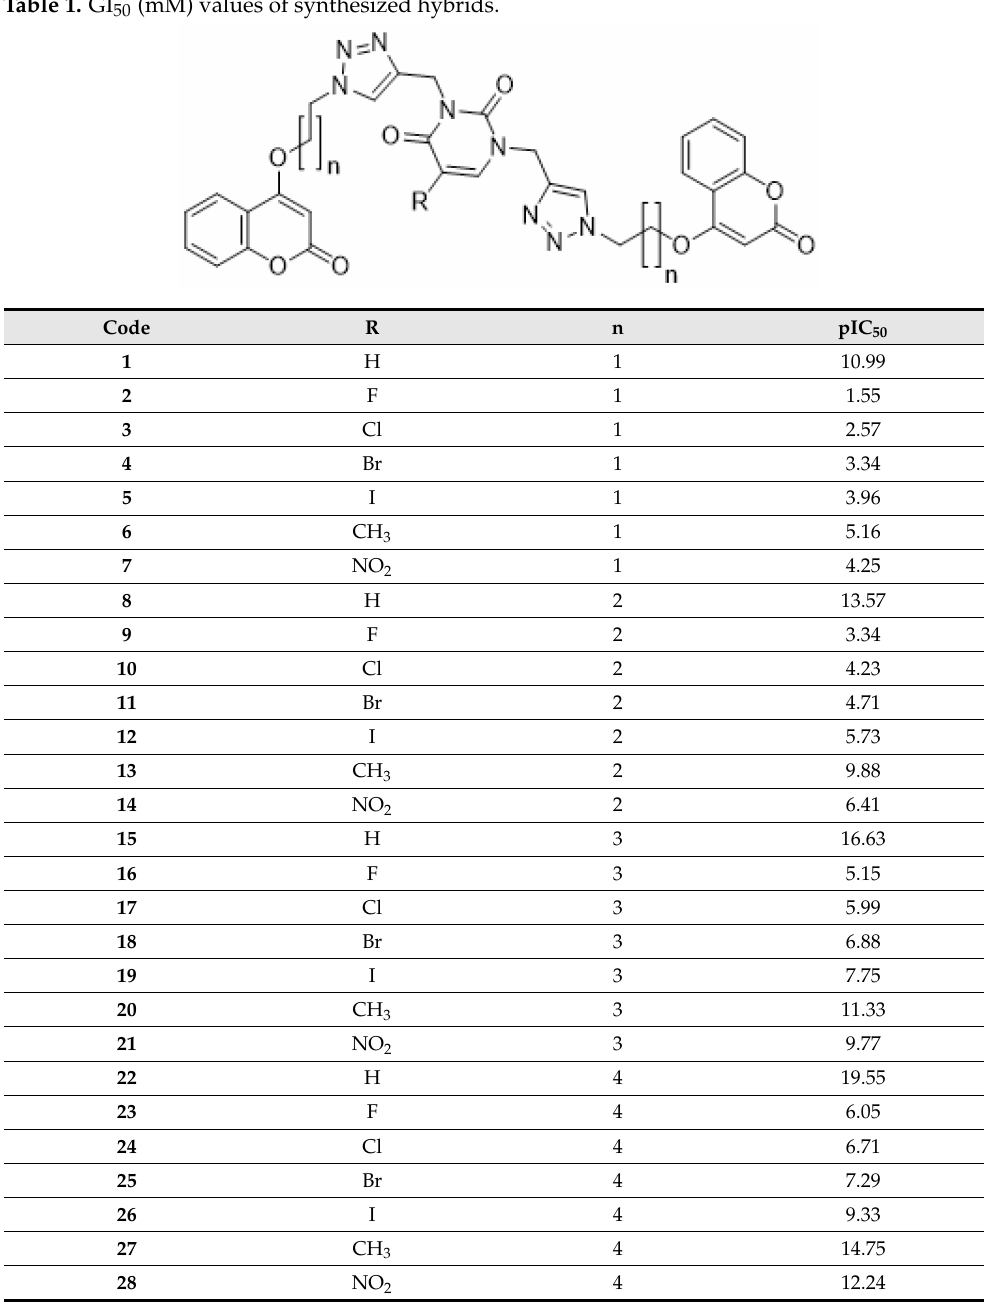
Table 1. GI 50 (mM) values of synthesized hybrids.